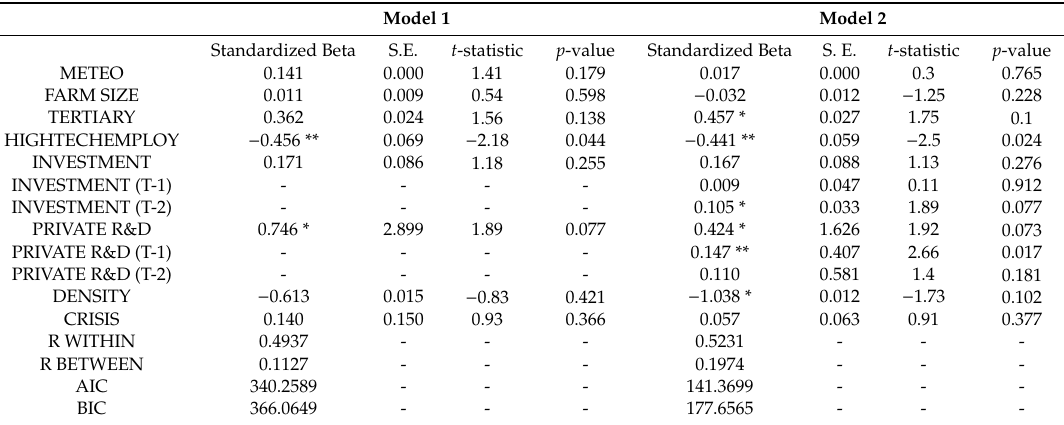
Table 3. Estimation